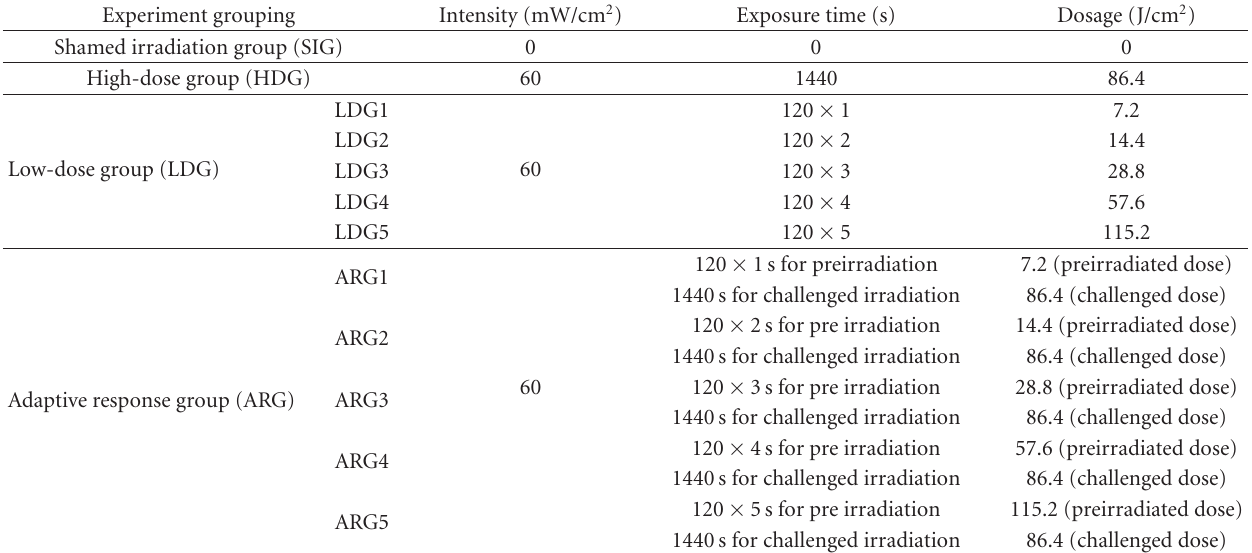
Table 1: UVA intensity, exposure time, and dosage.